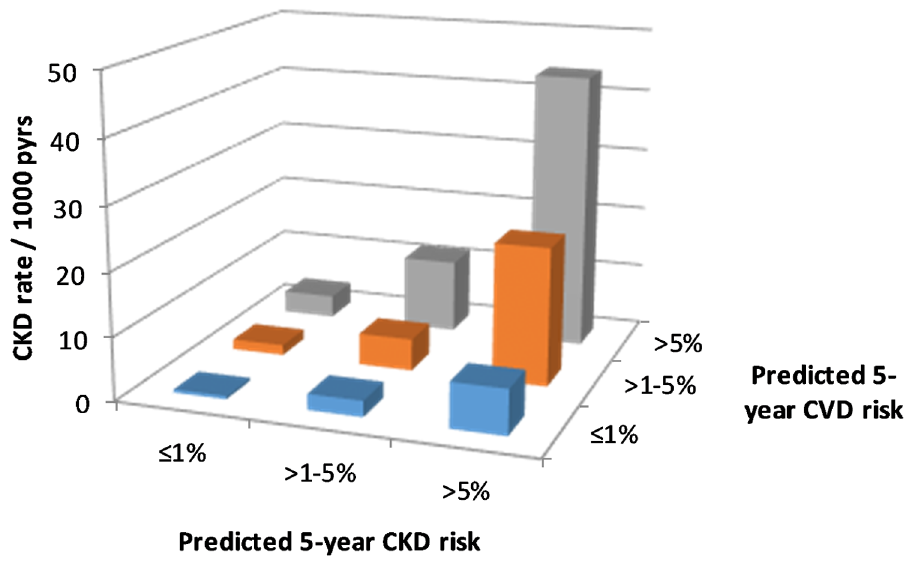
Fig 1. CKD event rates according to CKD and CVD risk. CKD, chronic kidney disease;CVD, cardiovascular disease;pyrs, person-years.